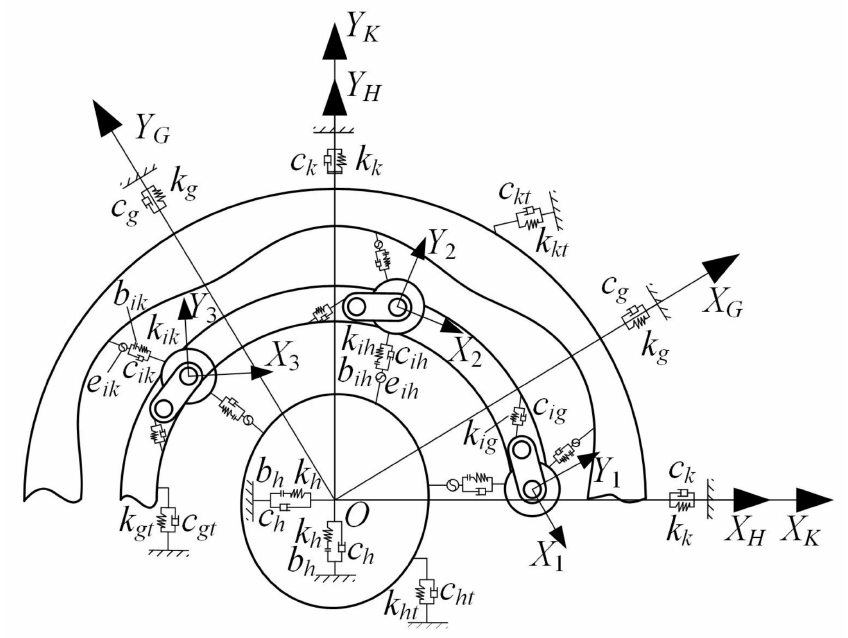
Figure 2. Dynamic equivalent calculation model of the two-tooth difference swing-rod movable teeth transmission